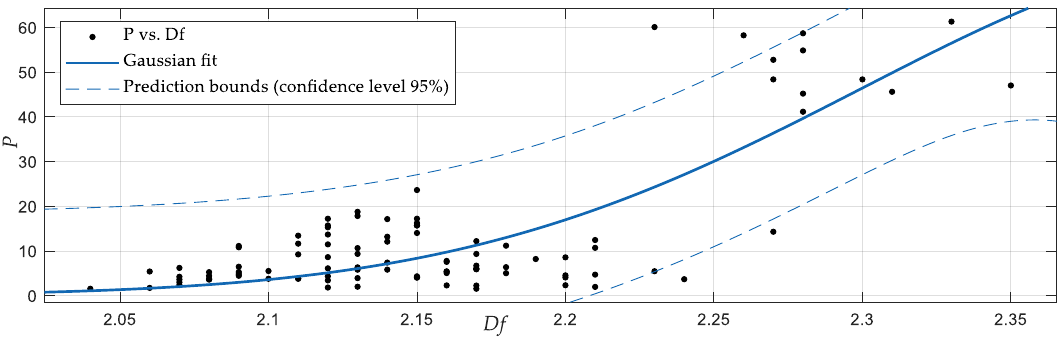
Figure 17. Material and loading parameter P vs. fractal dimension Df and their Gaussian fit.